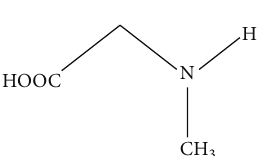
Figure 1: Chemical structure of